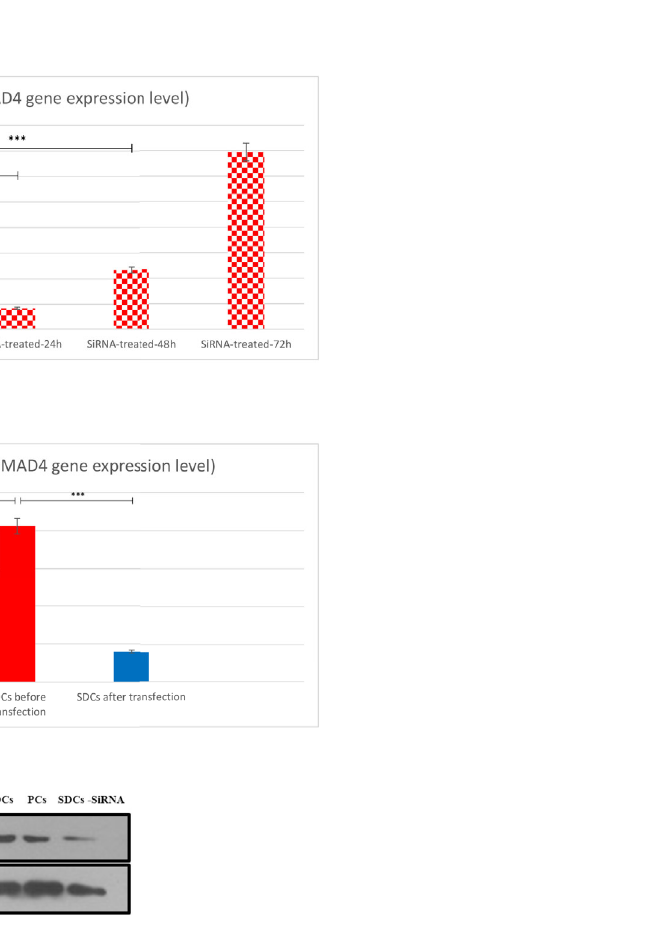
FIGURE 7 | Transfection of Parental Cells (PCs) With SiSMAD4 and its Effect on Expression Level of SMAD4. (A) Relative SMAD4 mRNA level in PCs was measured 24,48 and 72 hours after SMAD4 knockdown compared to PCS. (B) SMAD4 gene expression level of PCs and SDCs before and after transfection with SiSMAD4. (C) Measurement of protein SMAD4 expression by Western blotting in PCs and SDCs before and after SMAD4 knockdown. Data are represented as mean ± SD (n = 3 each). ** P < 0.05, and *** P <